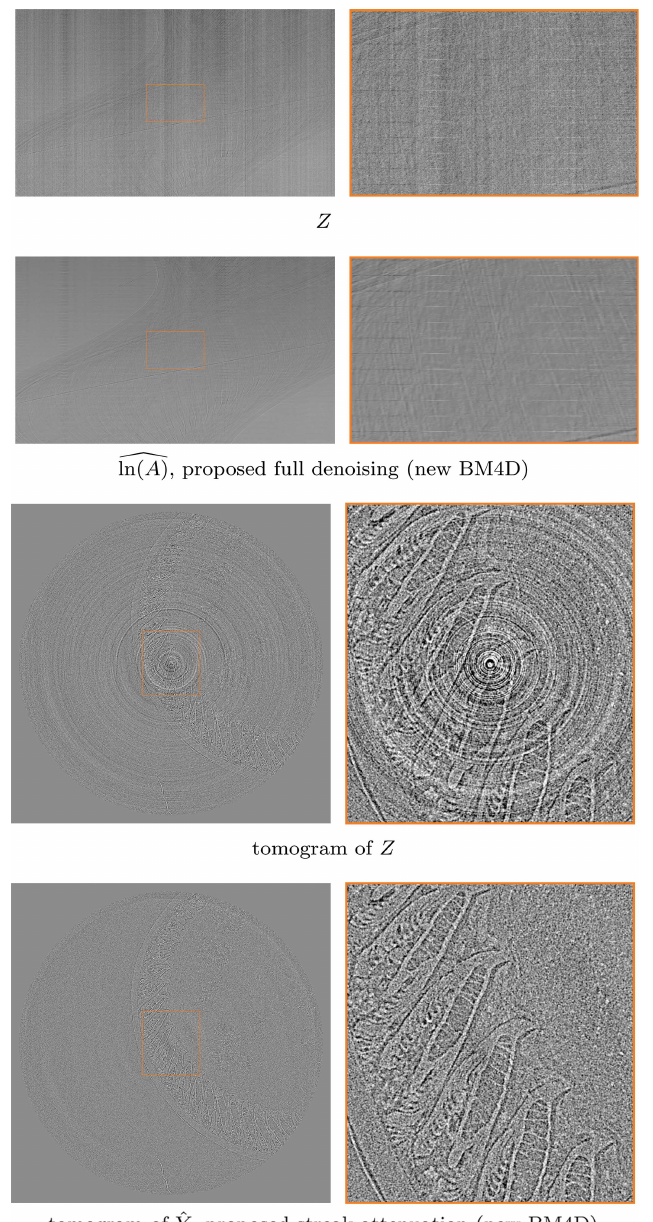
Figure 9 Figure 10 Denoising of the stack of projections of 00072. Top-to-bottom: display of Comparison of central slices of resulting tomograms after different a single sinogram of the noisy stack of projections Z (4), the denoising procedures on 00072, where individual tomograms are corresponding estimate of the underlying projections d ln ð A Þ ln ð A Þ from the horizontal lines each obtained with filtered back-projection. Displayed proposed procedure, and the corresponding tomograms of Z and the are slices of tomograms, reconstructed from, top-to-bottom: noisy estimates ^ YY of streak-free stacks Y (5), respectively, obtained with filtered projections Z (4), estimates ^ YY of the streak-free projections Y (5) back-projection. The tomogram for d ln ð A Þ ln ð A Þ is shown in Fig. 11. Although denoised with Ma¨kinen et al. (2021), ^ YY from the proposed streak the data present challenges through inconsistent noise intensities across denoising, and the result of the proposed full denoising d ln ð A Þ ln ð A Þ . Note the angular dimension, most streak noise and Poissonian noise is the loss of signal near the central part of the Ma¨kinen et al. (2021) attenuated without notable loss of signal. estimate, not observed in the proposed 840 Ymir Ma ¨ kinen et al. (cid:4) Ring artifact and Poisson noise attenuation J. Synchrotron Rad. (2022). 29 , 829–842